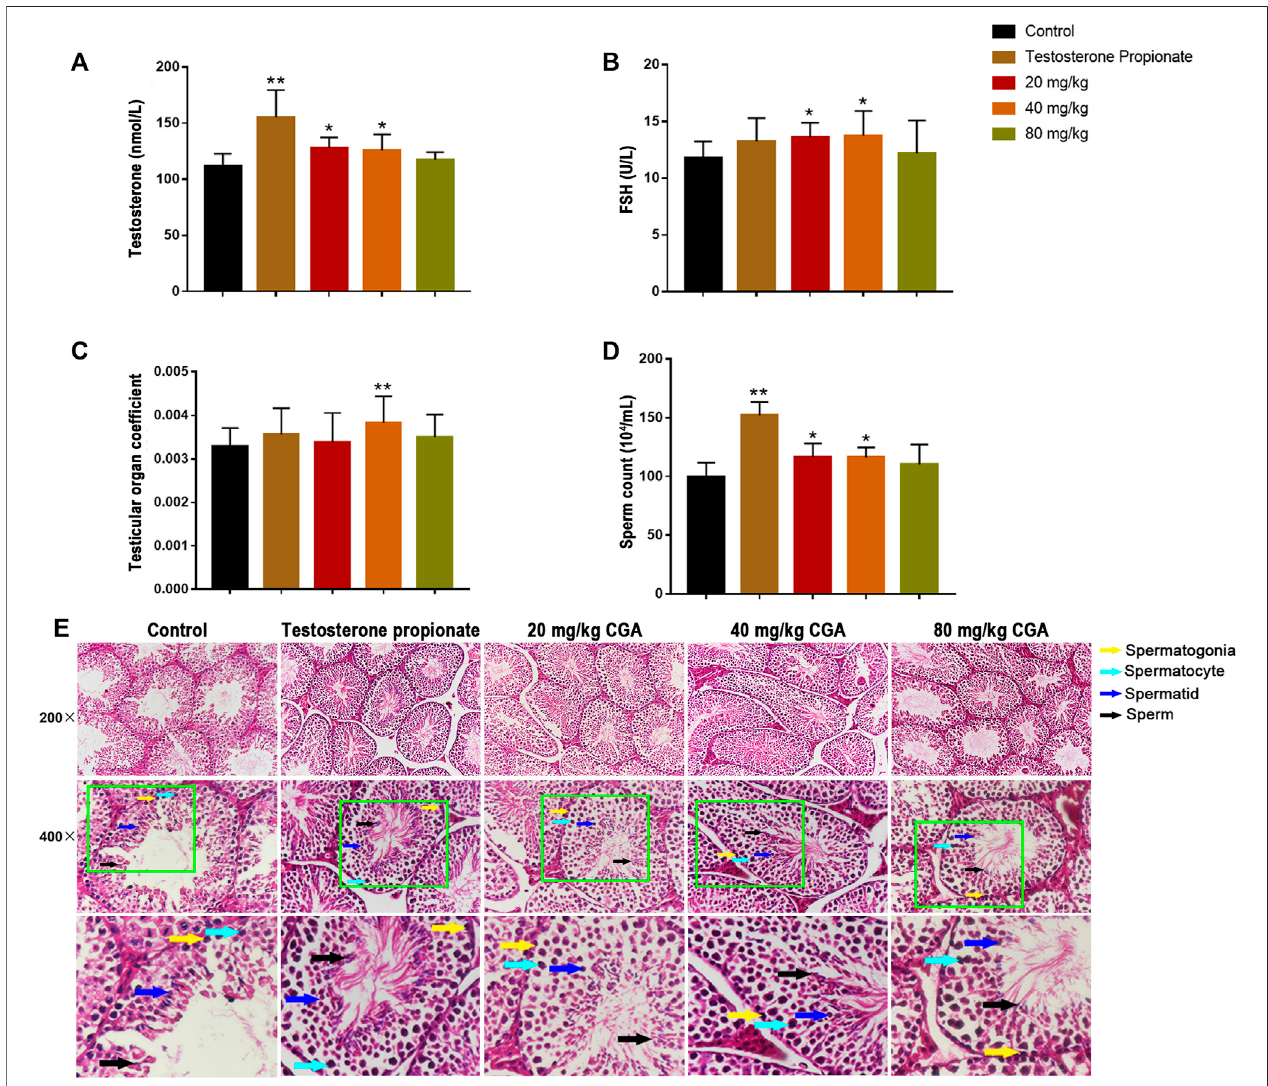
FIGURE3| TheeffectsofCGA onspermatogenesisinmice(Control: water;TestosteroneProplonate:5 mg/kg;CGA:20,40,80 mg/kg). (A) Theconcentrationof serum testosterone was analysed by ELISA. (B) The concentration of serum FSH was analysed by ELISA. (C) Testicular organ coef fi cient analysis of testes. (D) The spermcountanalysisofepididymis. (E) Haematoxylinandeosin(HE)staininganalysisoftestestreatedwithdifferentdosesofEFEE.Valuesareexpressedasthemean± SD ( n = 10).* p < 0.05, ** p < 0.01 vs control.